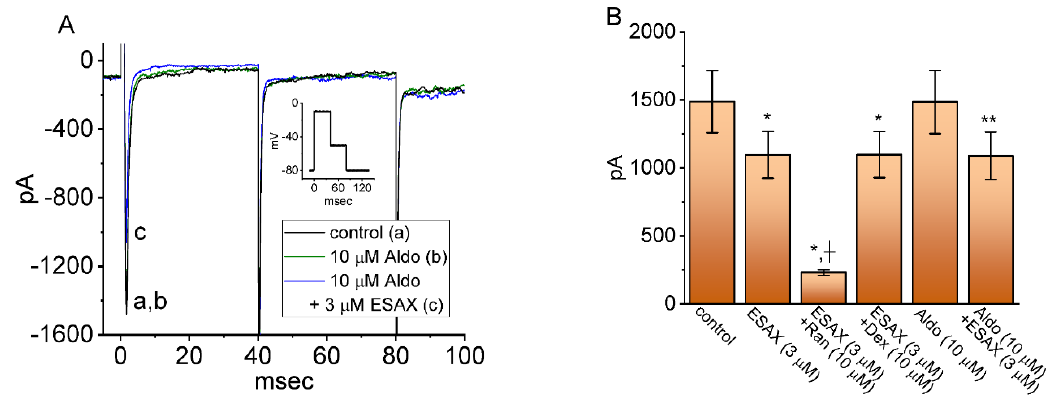
Figure 4. Comparison among effects of ESAX, ESAX plus ranolazine (Ran), aldosterone (Aldo), and aldosterone plus ESAX on the amplitude of peak I Na detected in GH 3 cells. Cells were kept bathed in Ca 2+ -free, Tyrode’s solution, and the recording electrode was filled up with Cs + -containing solution. The I Na was elicited by 40 ms depolarizing voltage command from − 80 to − 10 mV, and current amplitude at the start of the voltage pulse was measured. ( A ) Representative current traces obtained in the control (a) and during cell exposure to 10 μ M aldosterone (Aldo) (b) or 10 μ M Aldo plus 3 μ M ESAX (c). Inset shows the voltage pulse protocol. ( B ) Summary bar graph showing effects of ESAX, ESAX plus Ran, ESAX plus Dex, Aldo, and Aldo plus ESAX. Each bar represents the mean ± SEM ( n = 7–8). * Significantly different from control (i.e., none of the agents were present) ( p < 0.05), + significantly different from ESAX (3 μ M) alone group ( p < 0.05), and ** significantly different from aldosterone (10 μ M) alone group ( p < 0.05).